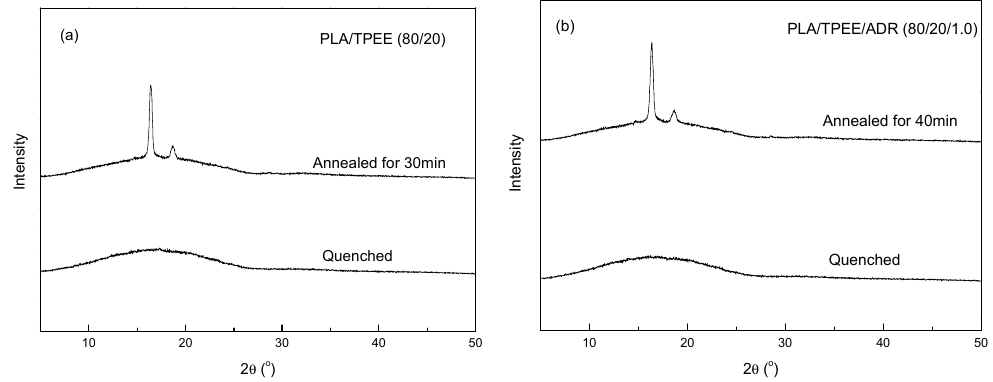
Figure 4. WAXD patterns of the quenched samples and the annealed samples held at temperature of 80 °C, ( a ) PLA/TPEE (80/20) samples; ( b ) PLA/TPEE/ADR (80/20/1.0) samples.